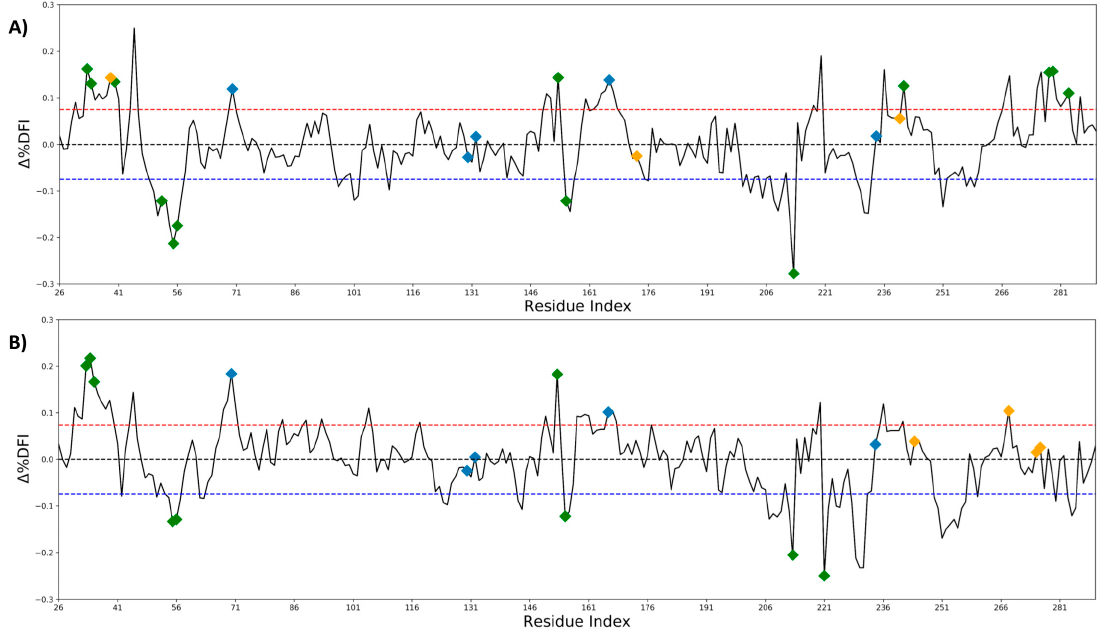
Figure 3. Comparison of the conformational dynamics of the wild type TEM-1 β -lactamase with the average DFI profile of the single point variants, distal from the catalytic region (blue diamonds), by calculating the difference in their %DFI profiles ( ∆ %DFI, y-axis) of the mutants impacting the hydrolysis of β -lactam antibiotics ( A ) and the mutations driving resistance through inhibitors ( B ). The red and blue dash line represents ± 1.0 times the standard deviation around mean (black dash line) of the differences between the profiles. We observed that the mutations (orange diamonds) impacted the dynamics of the catalytic region particularly around S70 and E166. In addition, we observed that many of the single point mutations explored in laboratory evolution experiments were found in regions with significant differences in their conformational dynamics when compared to the wildtype (green diamonds) [5]. This hints towards their possible contribution to the dynamics of the catalytic region.